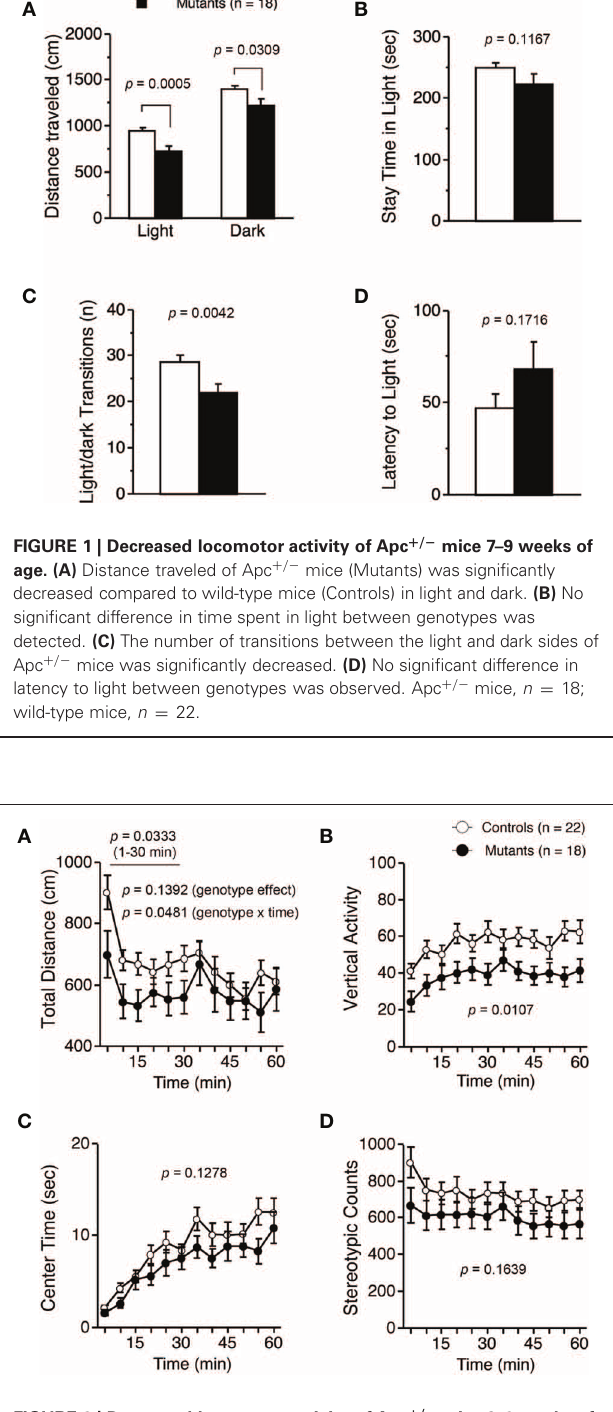
FIGURE 2 | Decreased locomotor activity of Apc + / − mice 8–9 weeks of age in an open-field test. (A) Total distance was significantly decreased in Apc + / − mice compared to wild-type mice in the first 30min and in the entire 60min. (B) Vertical activity of Apc + / − mice was significantly decreased. Apc + / − mice showed a slight, but not significant, decrease in time spent in the center area (C) , and stereotypic counts (D) . Apc + / − mice, n = 18; wild-type mice, n = 22.